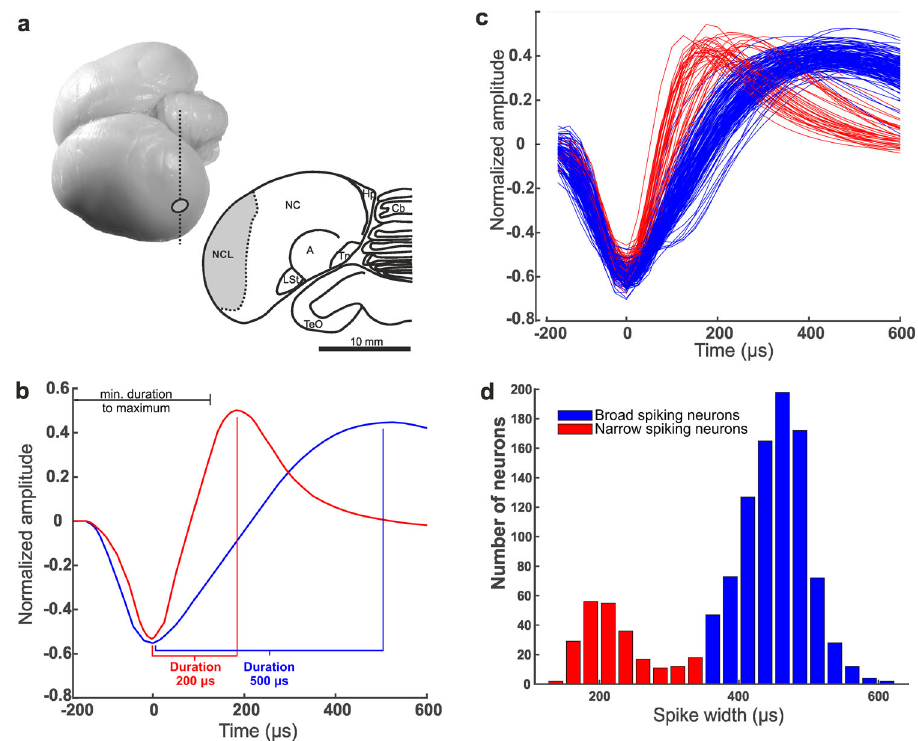
Fig. 2 Recording site and classi fi cation of broad- and narrow-spiking neurons. a Recording sites in the crow NCL. Dorsolateral view of a carrion-crow brain. Vertical dashed line indicates section level (A5.00) and implantation site (circle). Coronal section (level A5.00) through the brain of a carrion crow illustrating the extent of the nidopallium caudolaterale (NCL) in the caudal telencephalon. b Mean waveforms of one narrow (red) and one broad (blue) spiking neuron recorded from the same electrode. The waveform duration is de fi ned as the time from waveform valley to peak and was a characteristic used to classify neurons as broad- or narrow-spiking neurons. Only waveforms that showed a maximum no earlier than 300 µ s after the initial amplitude threshold was reached were included. c Normalized average waveforms of a random subset of 300 neurons aligned by their minimum. Waveforms of narrow-spiking neurons are depicted in red; waveforms of broad-spiking neurons are depicted in blue. d Bimodal distribution of waveform durations.